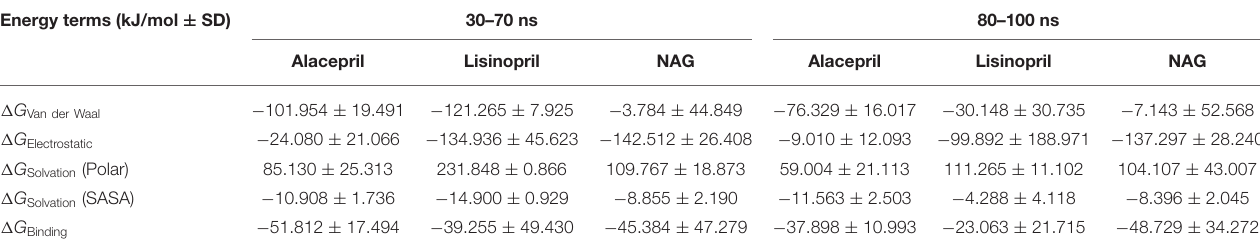
TABLE 4 | Binding-free energies calculations ( ± standard deviation; SD) for the investigated ligand- h ACE2 protein complexes. Energy terms (kJ/mol ±